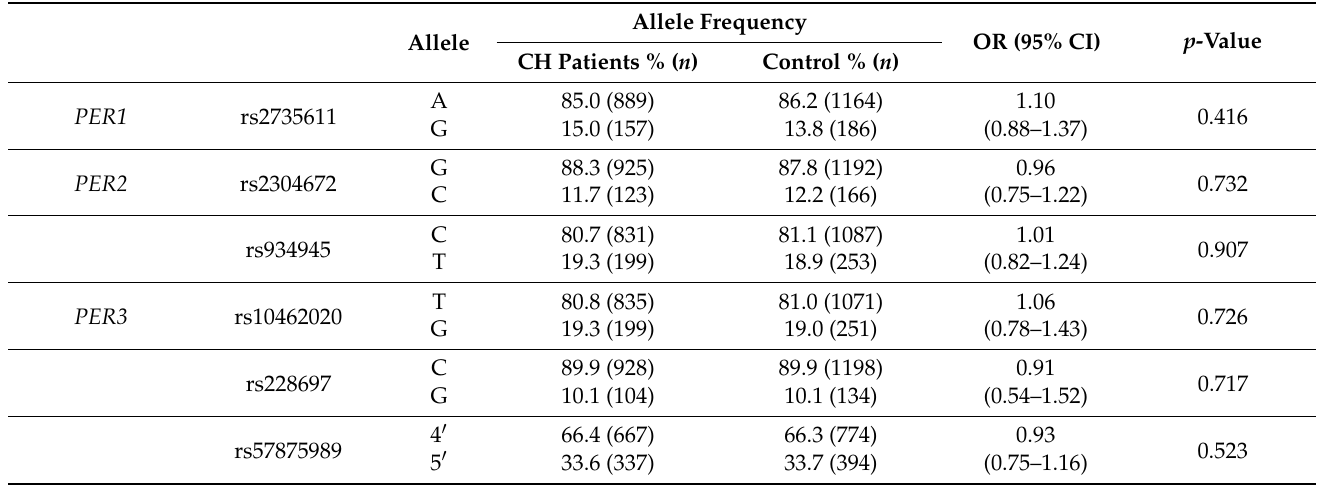
Table 2. Allele frequencies of genetic variants in PER1 , PER2 , and PER3 in cluster headache patients vs controls. Allele Frequency OR (95% CI) Allele